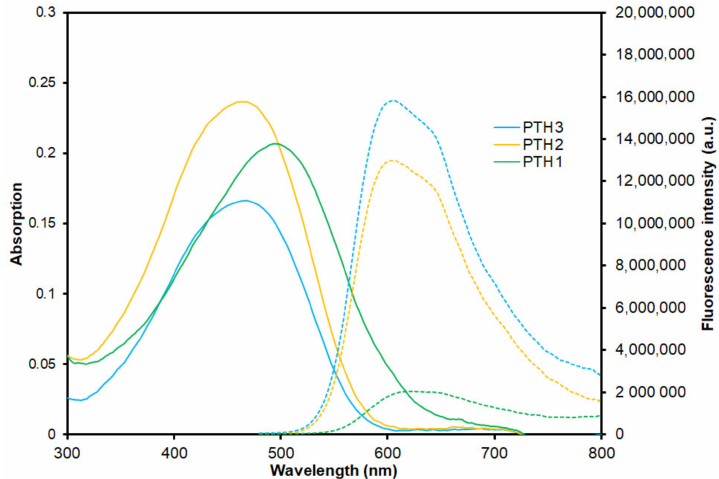
Figure 1. UV-vis. absorption spectra (solid line) and emission spectra ( λ exc = 466 nm) (dotted line) of PTH1 (0.37 µ M), PTH2 (0.68 µ M) and PTH3 (0.81 µ M) in